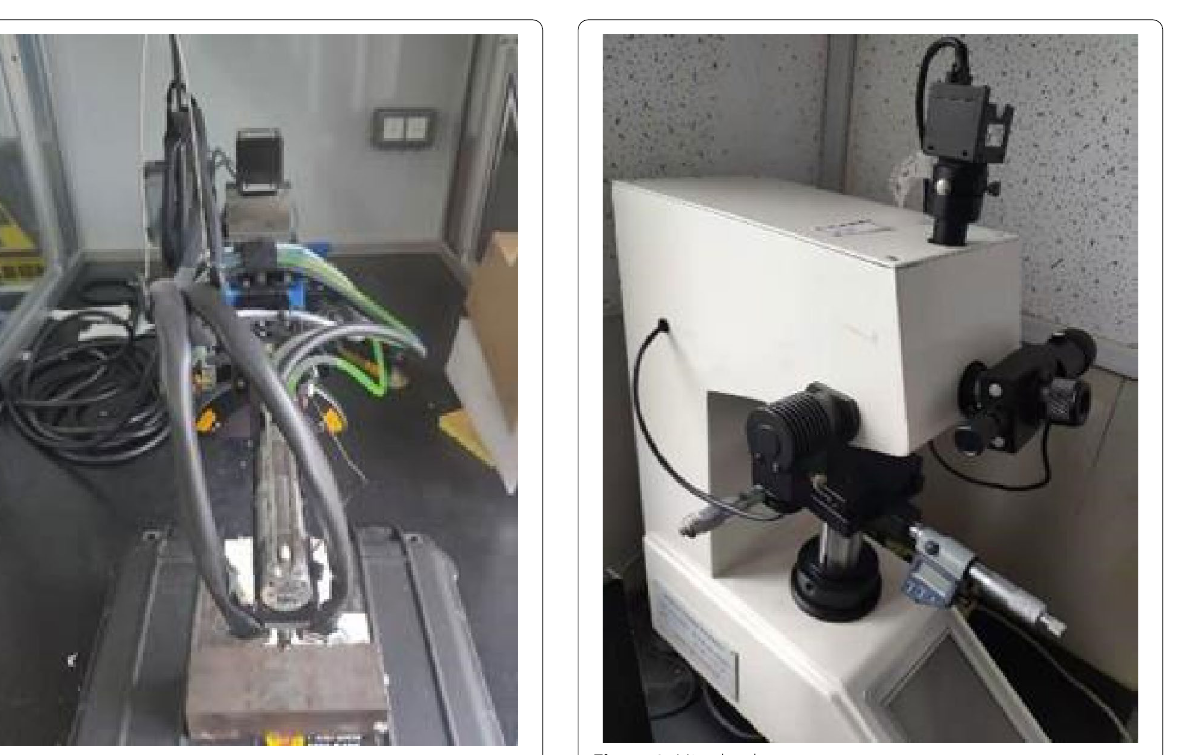
Figure 7 Residual stress analyzer Figure 8 Microhardness